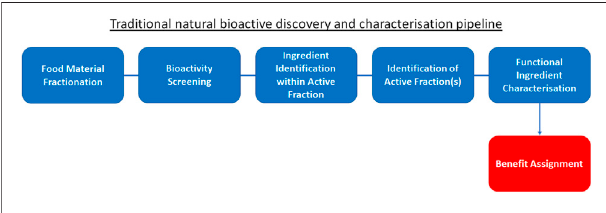
FIGURE 1 | Traditional natural bioactive discovery and characterisation pipeline. Traditional process (blue) to discovery and characterisation of functional ingredients. This process begins with food material fractionation, followed by bioactivity screening, identi fi cation of active fraction(s), ingredient identi fi cation within active fraction and functional ingredient characterisation. Finally,the bene fi tisassigned tothe bioactive (red) based on the screening